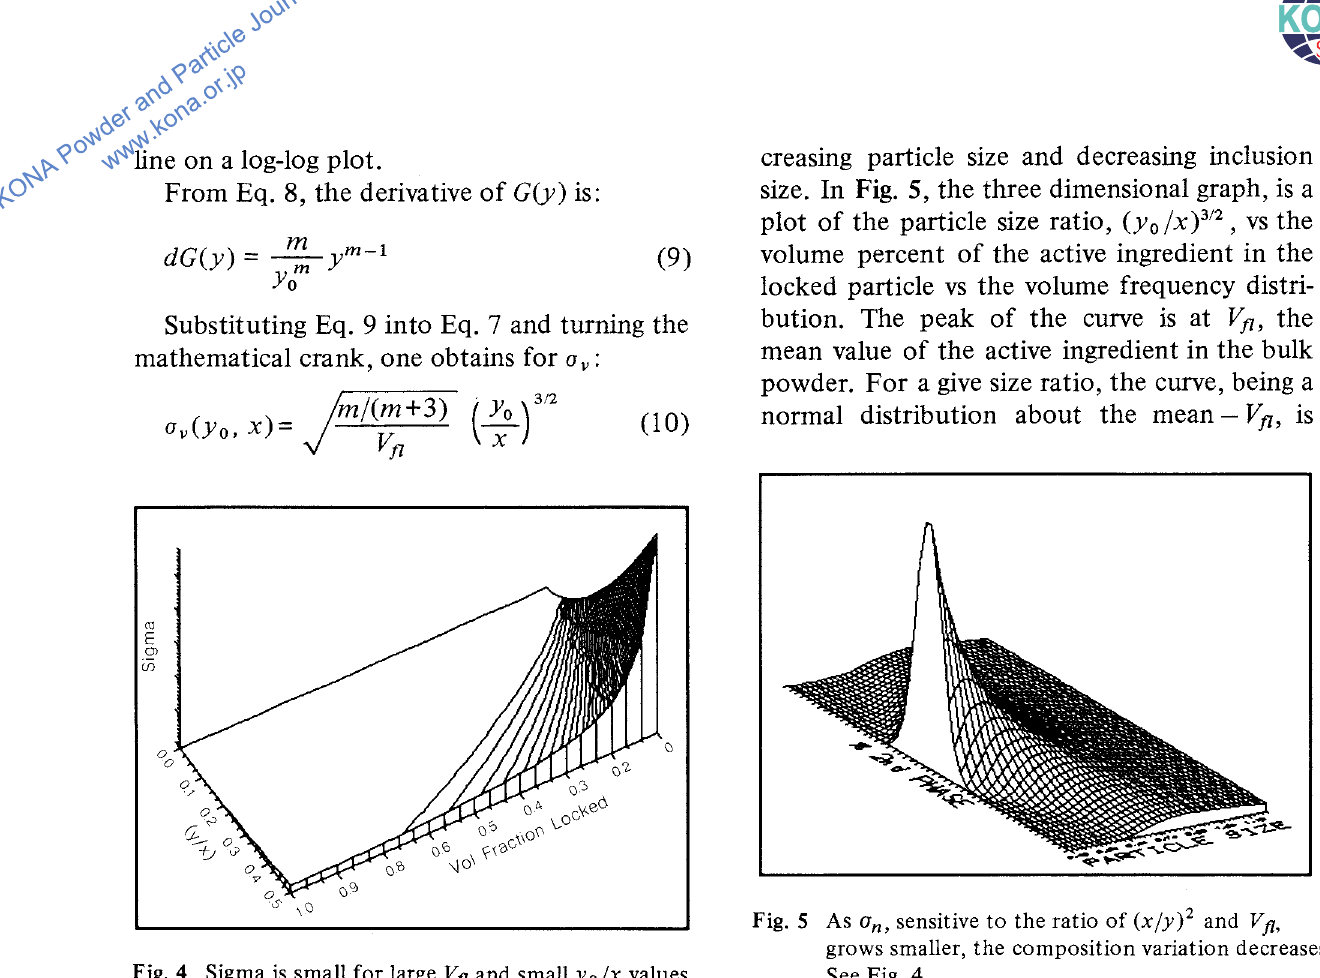
Fig. 4 Sigma is small for large Vfi and small y